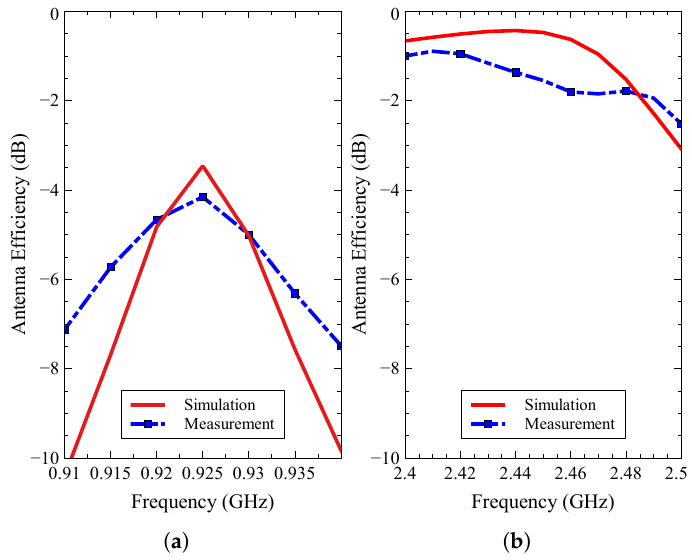
Figure 12. Simulated and measured total efficiency of the antenna at ( a ) low-frequency band and ( b ) high-frequency